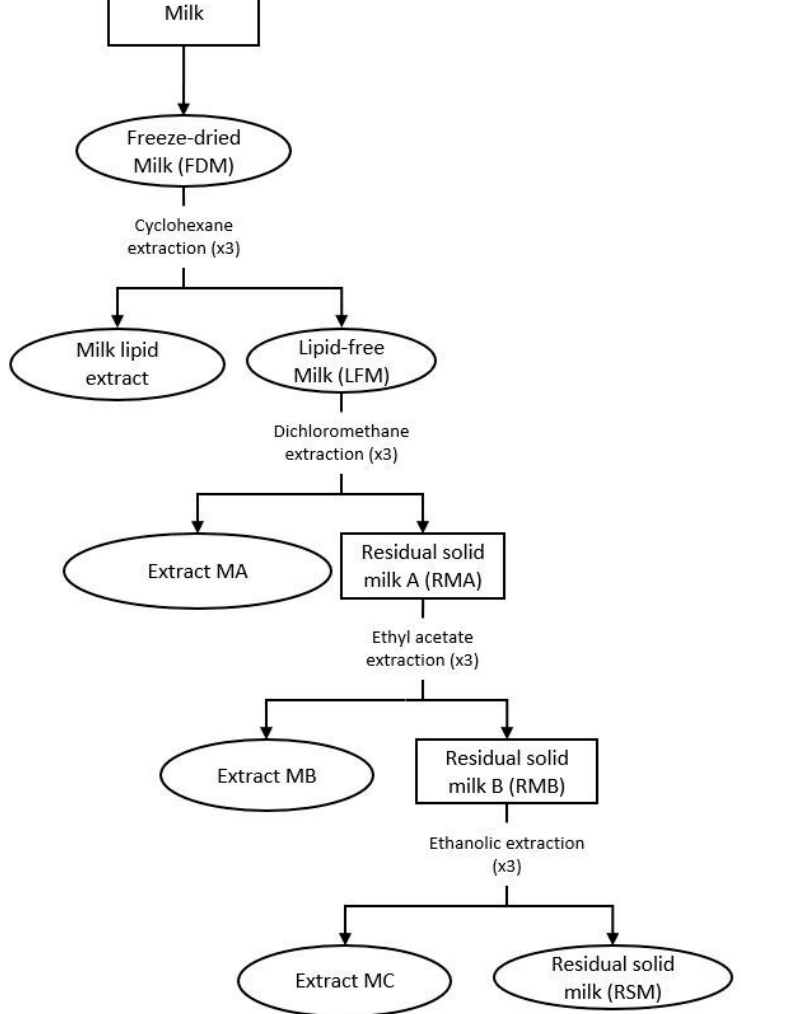
Figure 1. Preparation of the milk extracts. Ovals designate the milk extracts used for our biological studies (FDM (freeze-dried milk), milk lipid extract, LFM (lipid-free milk), and extracts MA (obtained with dichloromethane), MB (obtained with ethyl acetate), MC (obtained with absolute ethanol) and RSM (residual solid milk)).